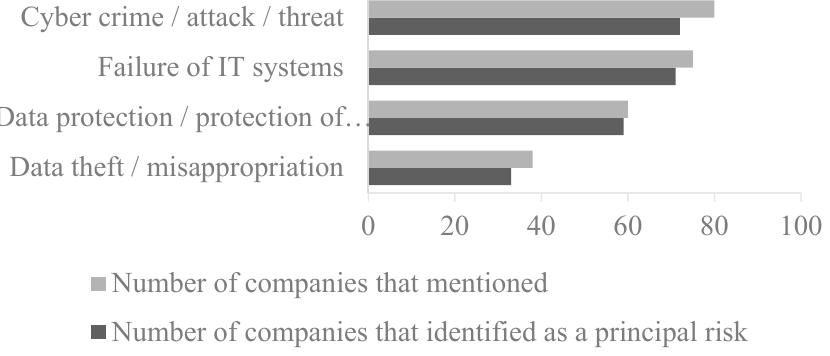
Figure 1. Types of cyber risks according to the annual Deloitte research “Cyber risk reporting in the UK 2016”.